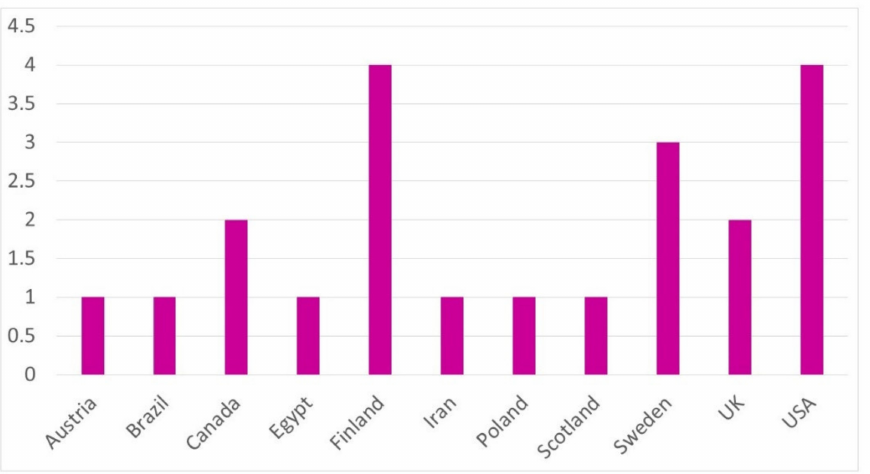
Figure 3. Countries where selected articles were published.